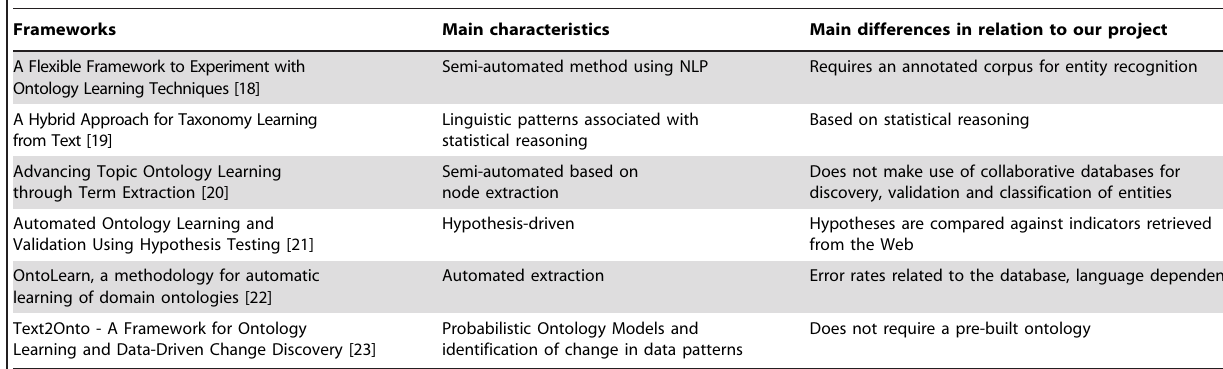
Table 2. Comparison of our method with previous